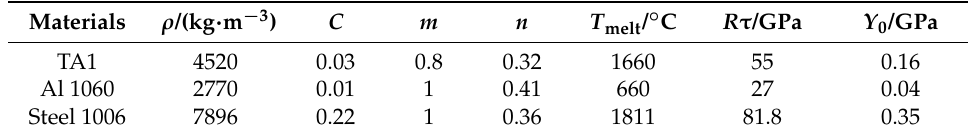
Table 3. Parameters using EOS and constitutive